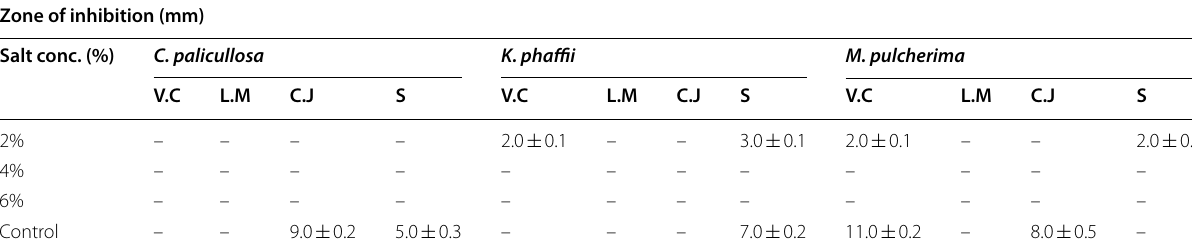
Salmonella sp (S.S) , Campylobacter jejuni (C.J) , Listeria monocytogenes (L.M) and Vibrio cholera (V.C)